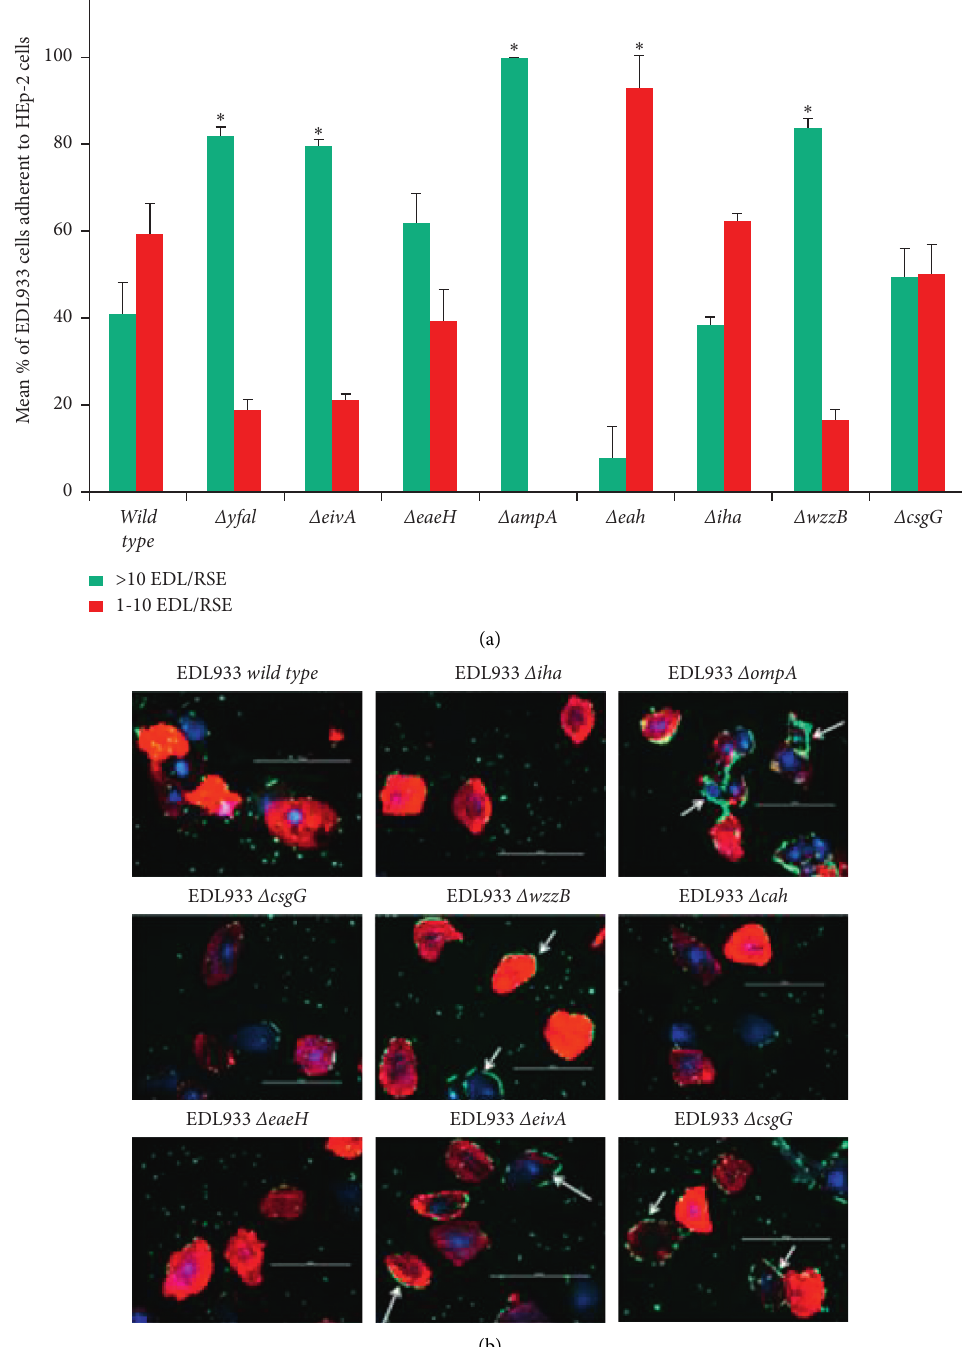
Figure 7: EDL933 adherence mutant phenotypes on RSE cells. The parental strain and the adherence-associated gene mutants of EDL933 were tested for adherence quantitatively (a) and qualitatively (b) on RSE cells. As the results show, the mutants of EDL933 have a lot of adherence differences compared to the parental strain. These differences are loss of adherence (EDL933 Δ iha and Δ cah ) and a phenotypic switch from aggregative moderate adherence to the same aggregative strong adherence exhibited by EDL933 on RSE cells ( Δ yfaL , Δ wzzB , Δ ompA , and Δ eivA ). (a) Each bar is representative of four technical replicates per slide where 20 cells/spot were counted over two trials. The bar is the mean percentage of adherent bacteria ( > 10 or 1–10) per RSE cell over the two trials. (b) Immunofluorescence of EDL933 adherence pattern on RSE cells. Bacteria are labeled with green, RSE cell cytokeratins with red, and RSE cell nuclei with DAPI (blue) fluorescent staining. The scale bar for each panel is set to 100 μ m and the white arrows show the O157 on RSE cells. Black asterisks denote p value < 0.05 for gain of adherence and red for loss of